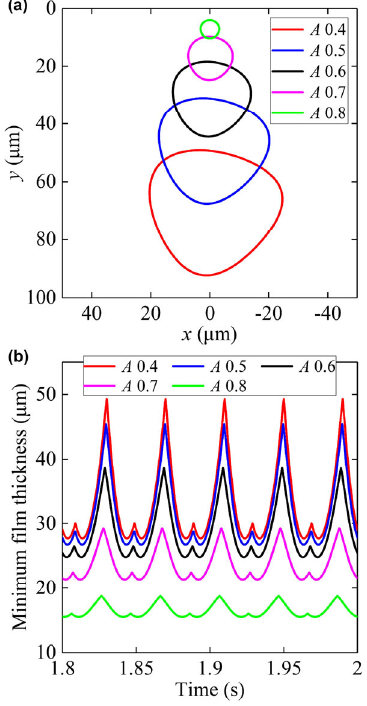
Fig. 4 (a) Journal center orbits and (b) dynamic minimum film thicknesses of a TPJB with static loads for different preload